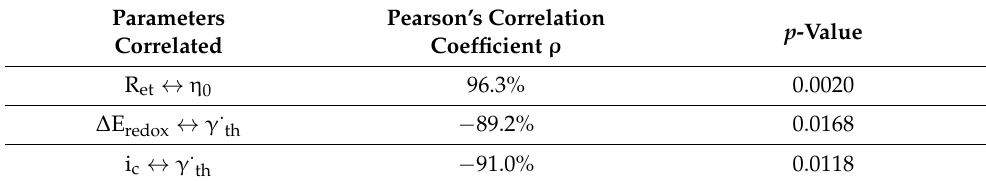
Figure 3. EIS measurements of the examined electrodes at a DC potential of 0.2 V, the amplitude of 0.005 V in the frequency range from 1 to 100 kHz vs. Ag/AgCl/1.0 mol L − 1 KCL reference electrode, and a gold wire as the auxiliary electrode in 5 mM ferri/ferrocyanide. Table 3. Statistically significant correlations between measured parameters.